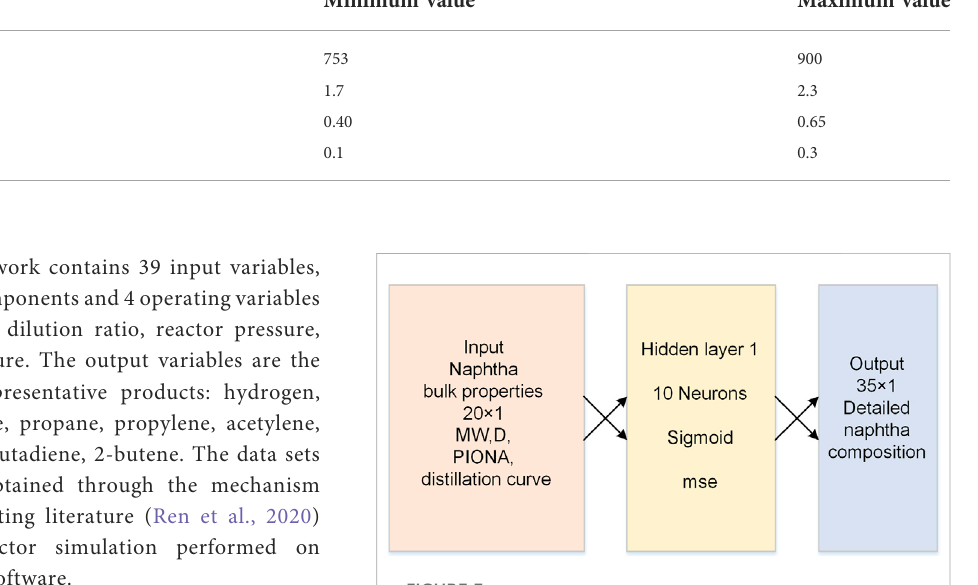
FIGURE 3 The network structure of the direct ANN